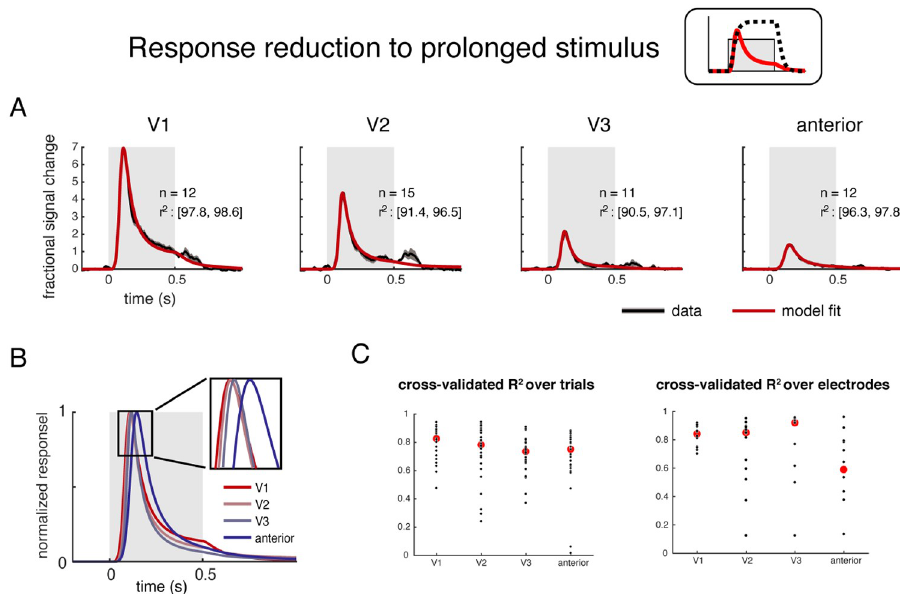
Fig 3. The DN model captures the response reduction for prolonged stimuli at different cortical locations. (A) The DN model fits (red) accurately describe the ECoG broadband time course (black) in multiple ROIs. Data were averaged across trials and electrodes within ROIs, and models were fit to the average time course. Each trial had a 500-ms stimulus (gray box) followed by a 500-ms blank. Plots show the mean and 50% CI for data (bootstrapped 100 times across electrodes within an ROI), and the model fit averaged across the 100 bootstraps. The number of electrodes per ROI and the 50% CI of model accuracy (r 2 per bootstrap) are indicated in each subplot. (B) The model fits for the 4 ROIs are plotted together, scaled to unit height. For this plot, the latency was assumed to be 0 for each ROI, so that the difference in time to peak reflects a difference in integration time rather than a difference in response latency. (C) Cross-validation over trials and over electrodes. 30-fold leave-one-out cross validation over trials was performed on the 30 repeats. Red dots represent the median r 2 across trials, and black dots are the leave-one-out prediction to each trial. Leave-one-out cross validation was also performed over electrodes. Details of the cross-validated fit were presented in S3 Fig.